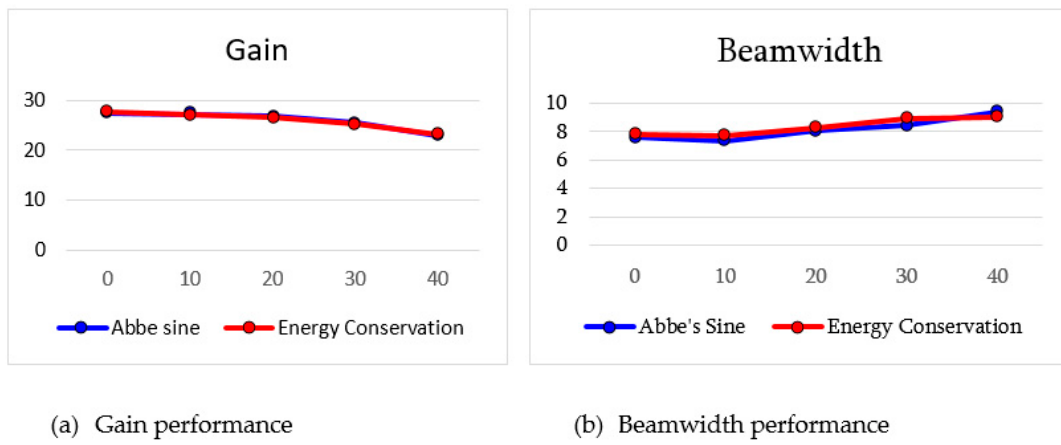
Figure 24. Performance comparison for both types of lens.